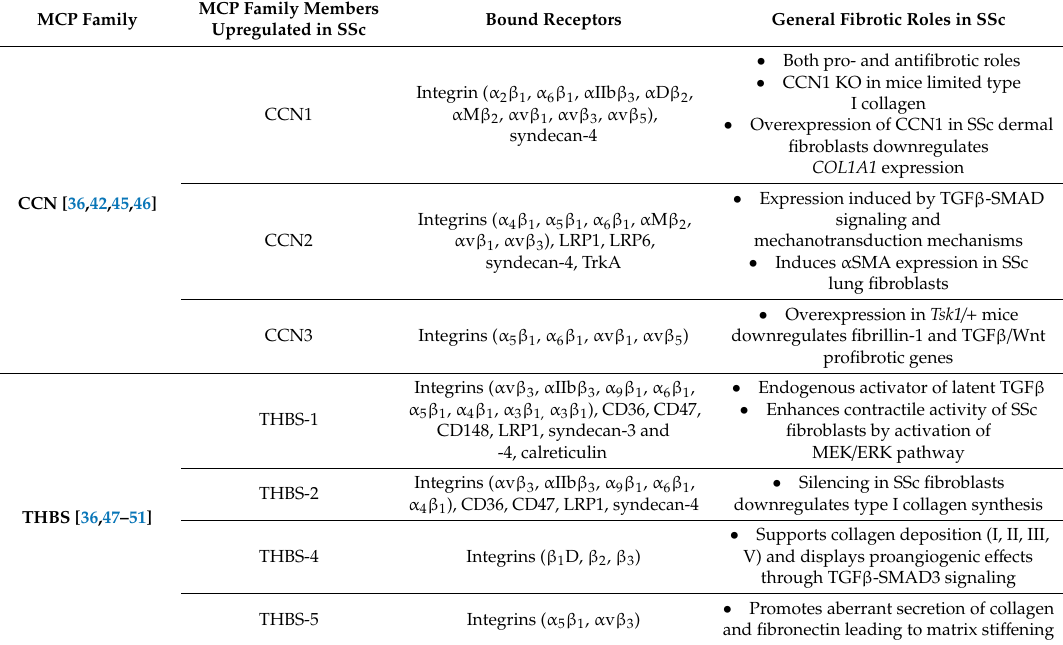
Table 1. Summary of major matricellular proteins (MCPs) in systemic sclerosis (SSc)